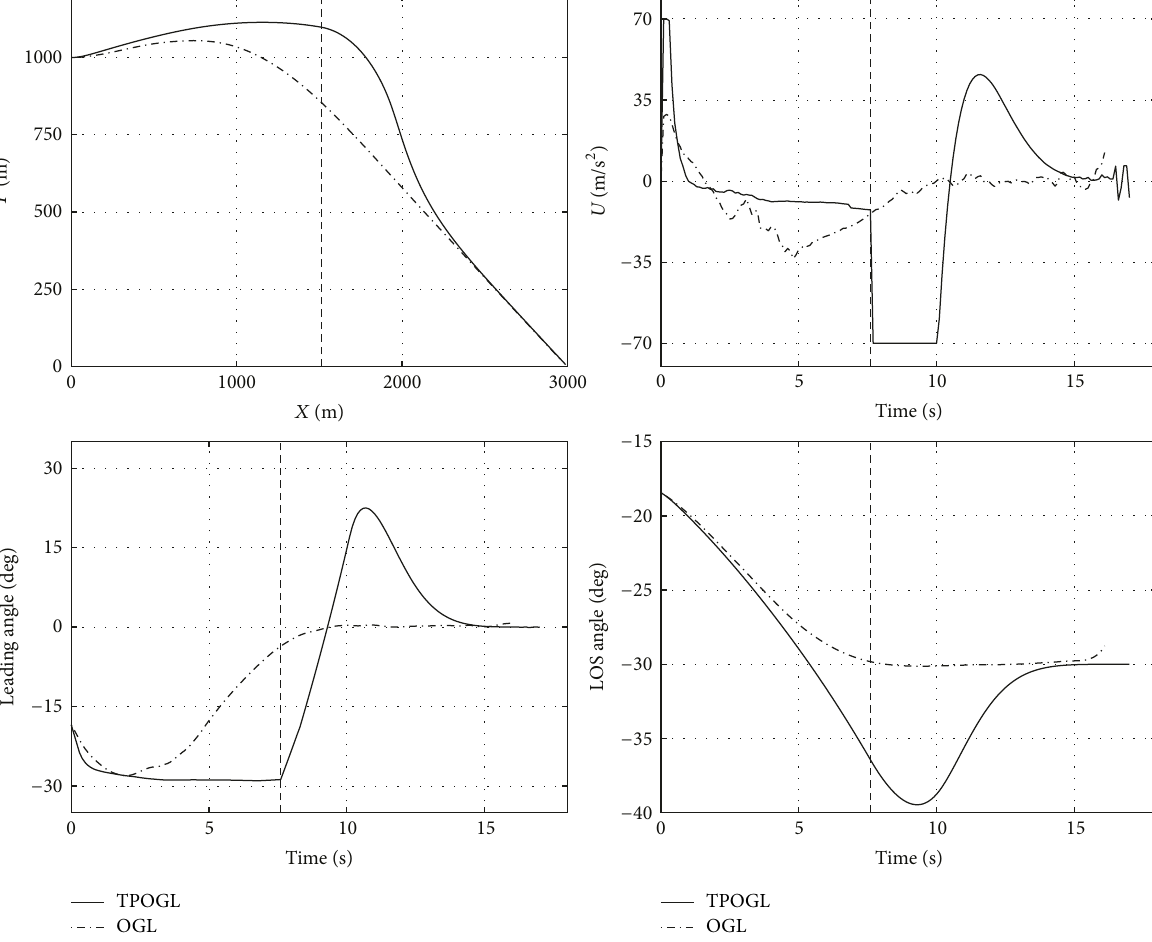
Figure 6: Simulation results comparisons against stationary